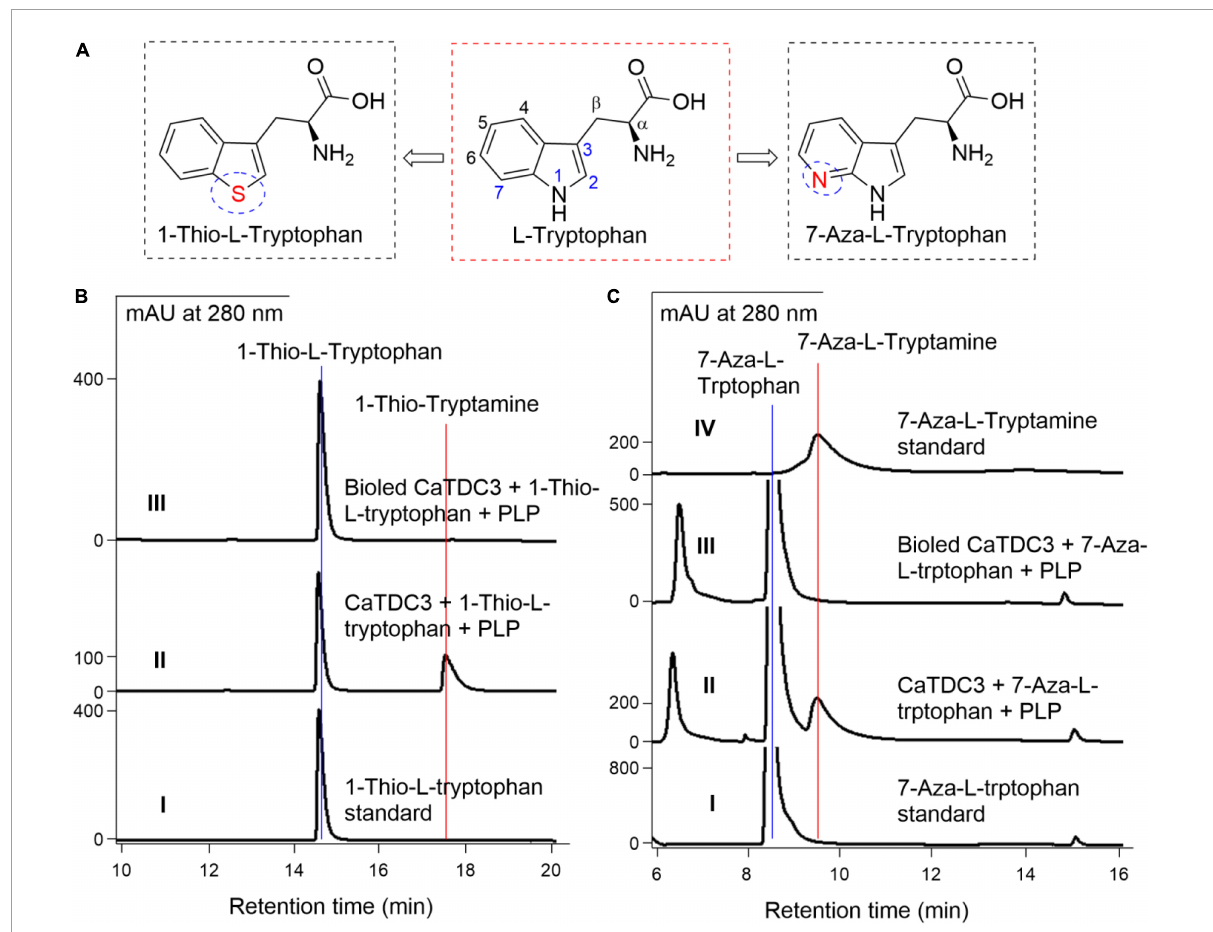
FIGURE10 The effects of –NH displacement and aza-aromatic ring of L-tryptophan on CaTDC3’s decarboxylative activity. The substrate with distinct chemical structures from L-tryptophan tested in present work (A) . (B) HPLC-DAD analyses of the standard 1-thio-L-tryptophan (panel I), the enzymatic reaction mixture with CaTDC3 (panel II), and boiled CaTDC3 (panel III) as catalyst, respectively. (C) HPLC-DAD analyses of the standard 7-aza-L-tryptophan (panel I), the enzymatic reaction mixture with CaTDC3 (panel II), and boiled CaTDC3 (panel III) as catalyst, respectively, and the standard 7-aza-tryptamine (panel